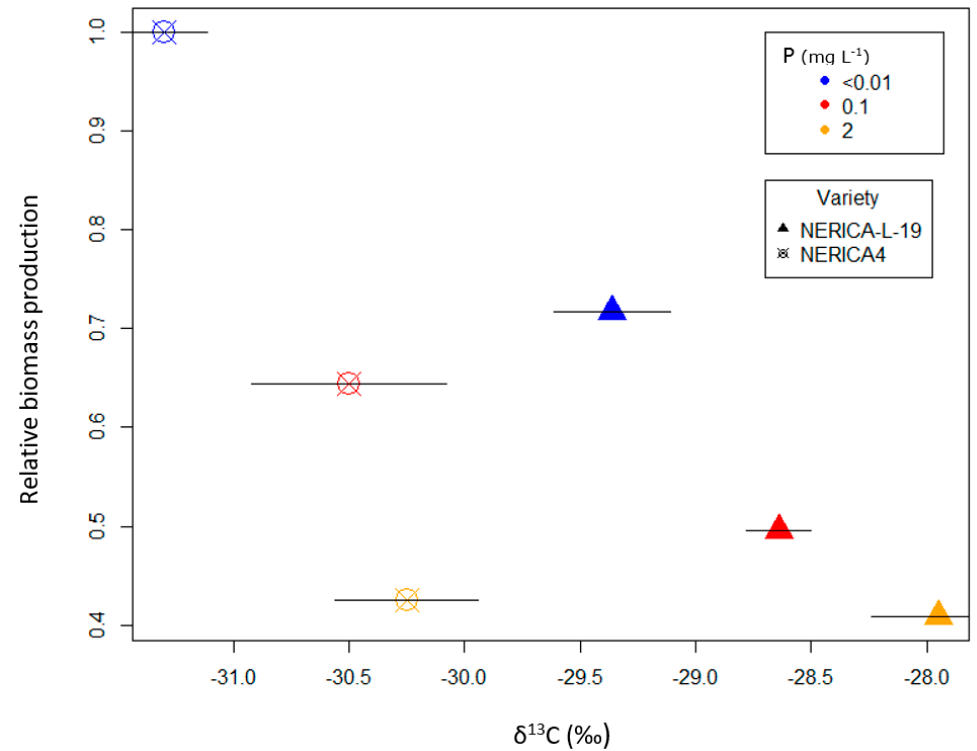
Figure 1. Relative biomass production (under water stress relative to field capacity) plotted against carbon isotope discrimination ( δ 13 C) in two rice varieties (NERICA-L-19 and NERICA4) grown in lowland soil. P was applied to achieve P concentrations in soil solution of <0.01 mg L − 1 , 0.1 mg L − 1 , and 2 mg L − 1 . Error bars represent the standard error on the δ 13 C.